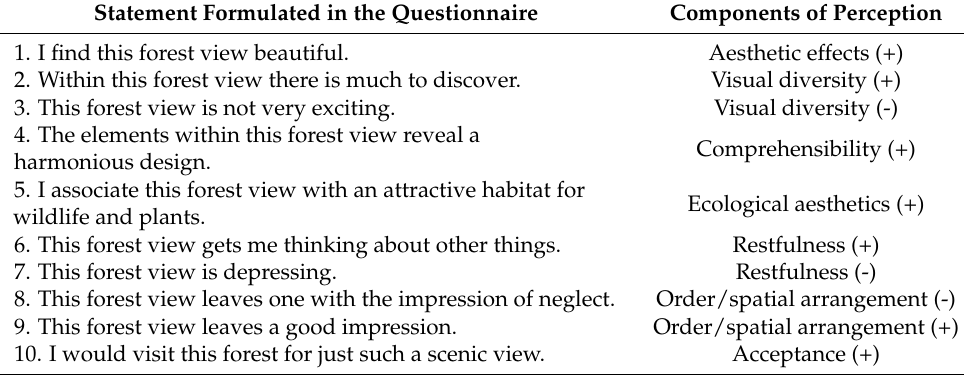
Table 2. Overview of the ten statements in the questionnaire and the associated components of perception according to Hauru et al. [34] combined with the type of statement formulation (+ positive, - negative control